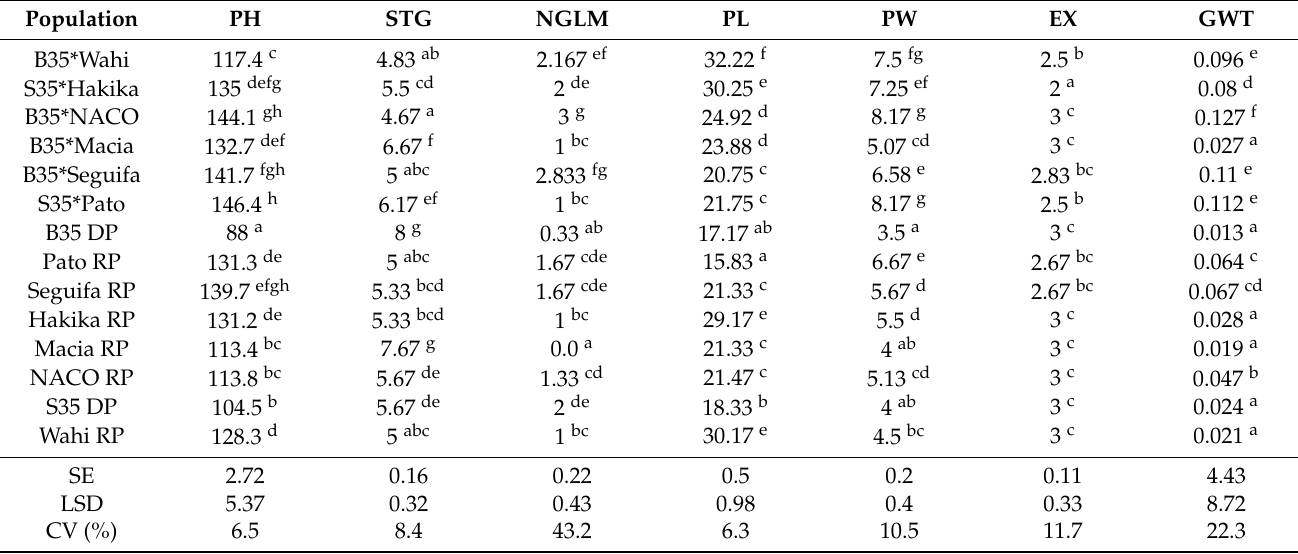
Table 2. Five per cent of the best performance BC 2 F 1 populations and their